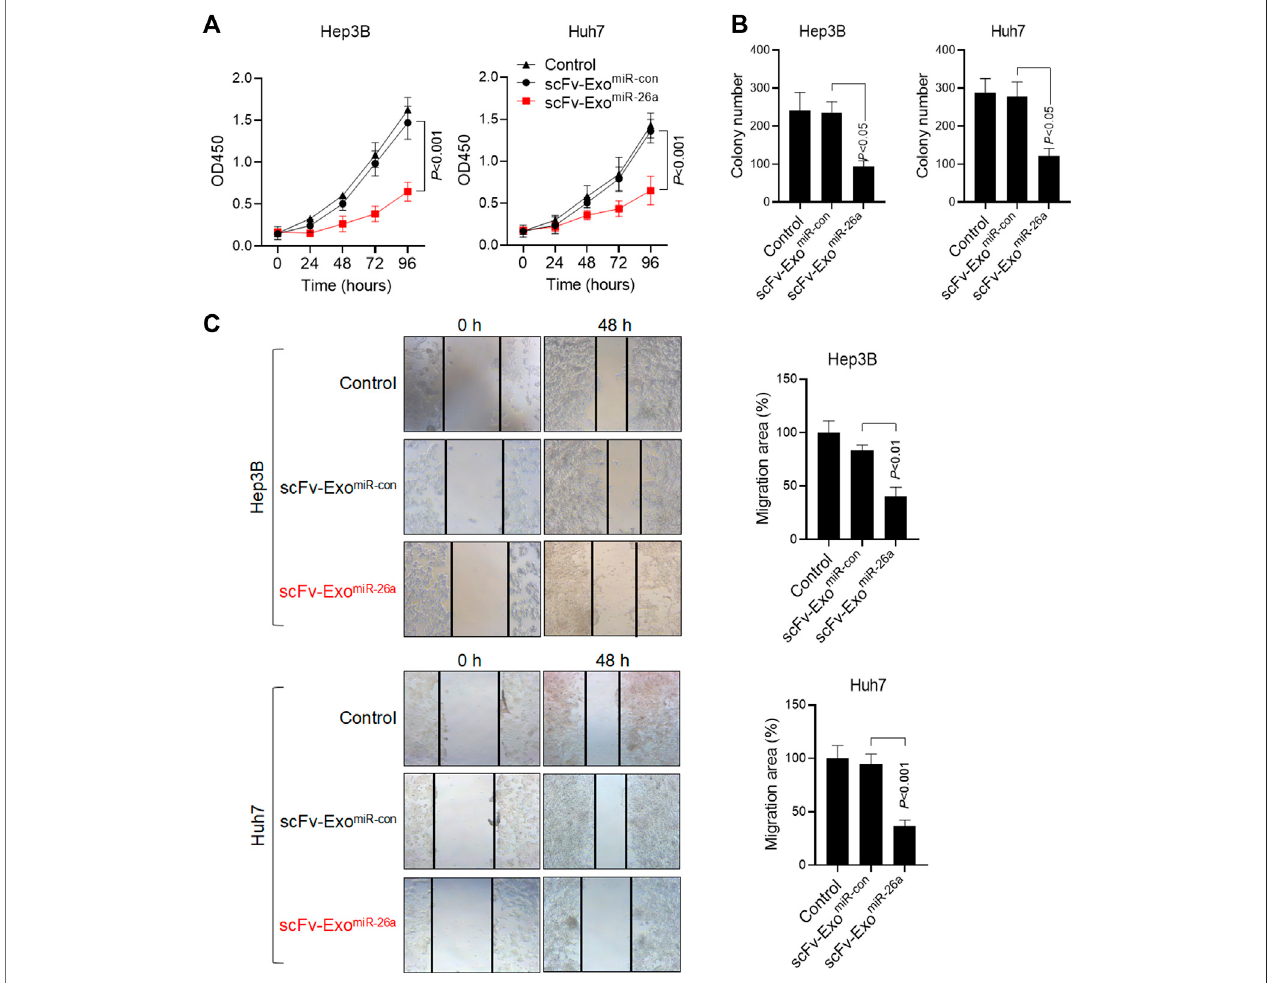
FIGURE4| ExposuretomiRNAdrug-loadedexosomesinhibitedHCCproliferation. (A) MTTdetectionofcellproliferationin293T,HepG2,andHuh7cellsafterthe addition of 20 μ g miRNA drug-loaded exosomes. (B) The number of cell clones was counted after the addition of drug-loaded exosomes. (C) The migration of HepG2 and Huh7 cells in different treatment groups was detected by scratch assay (100 × ). Relative migration area was quanti fi ed (bar charts).